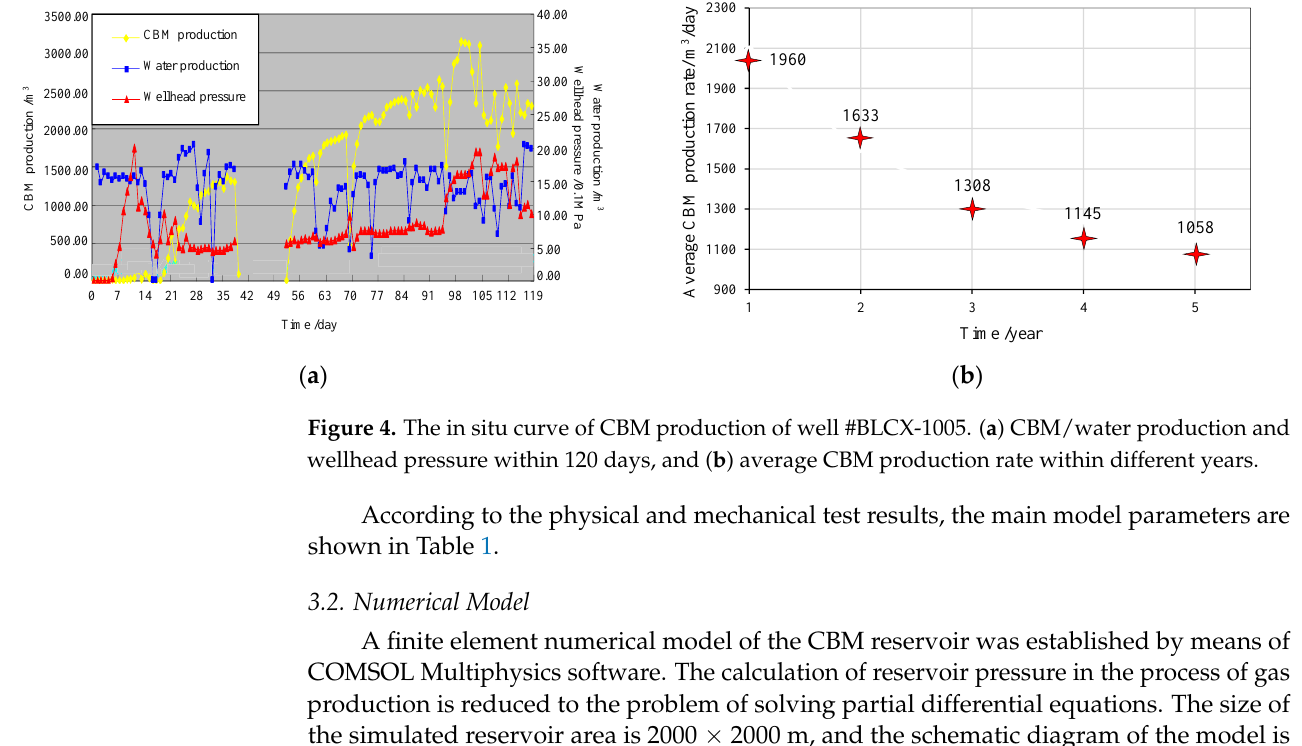
Table 1. Main model parameters.